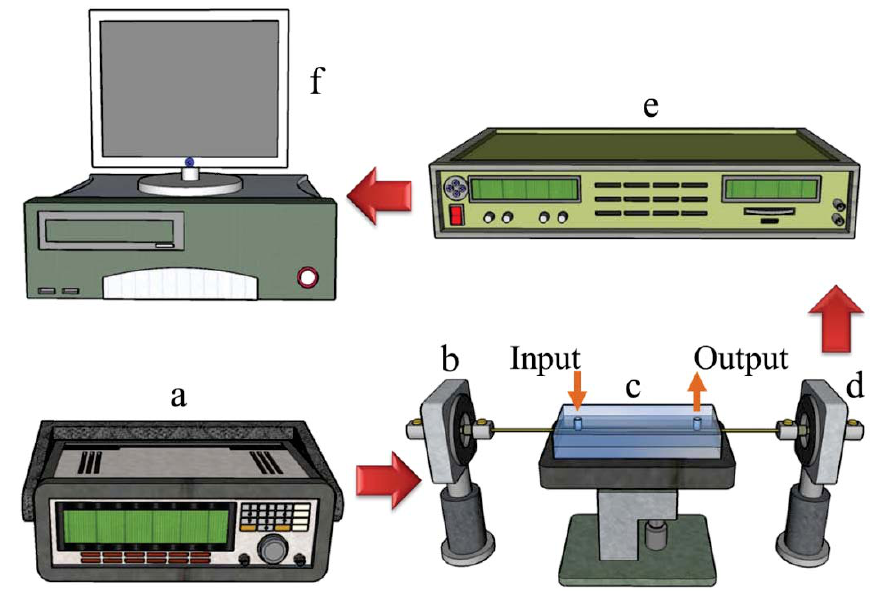
Figure 14. Schematic of the experimental setup for creating sensing measurements: ( a ) function generator (Agilent Inc. Model: 33220A); ( b ) LED light source (Model: EHP-AX08LS-HA/SUG01-P01, Everlight Inc.); ( c ) sensing chip; ( d ) photo diode (Model PD-ET2040, EOT Inc., Traverse, MI, USA); ( e ) lock-in amplifier (Model 7225, Signal Recovery Inc., Oak Ridge, TN, USA); and ( f ) computer.